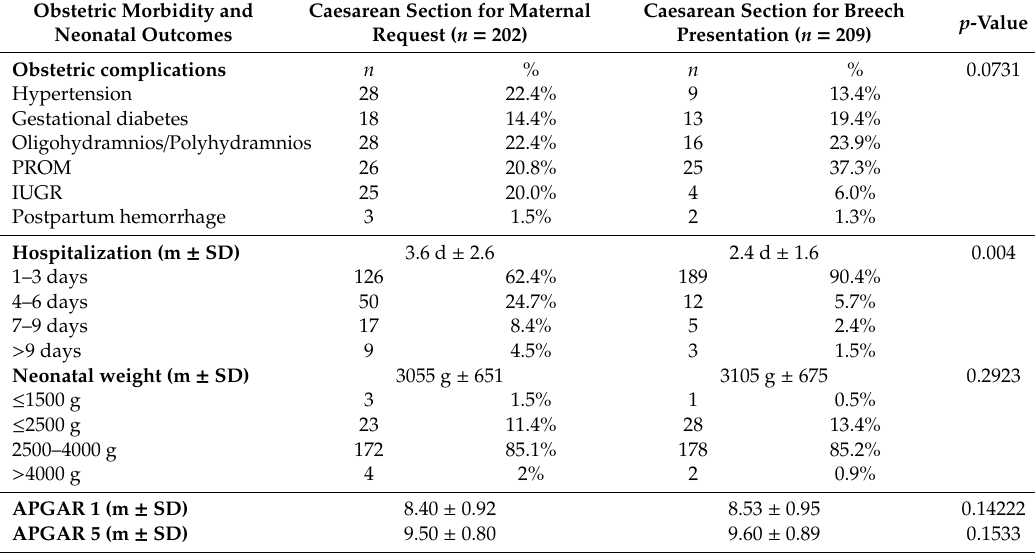
Table 2. Obstetric morbidity and neonatal